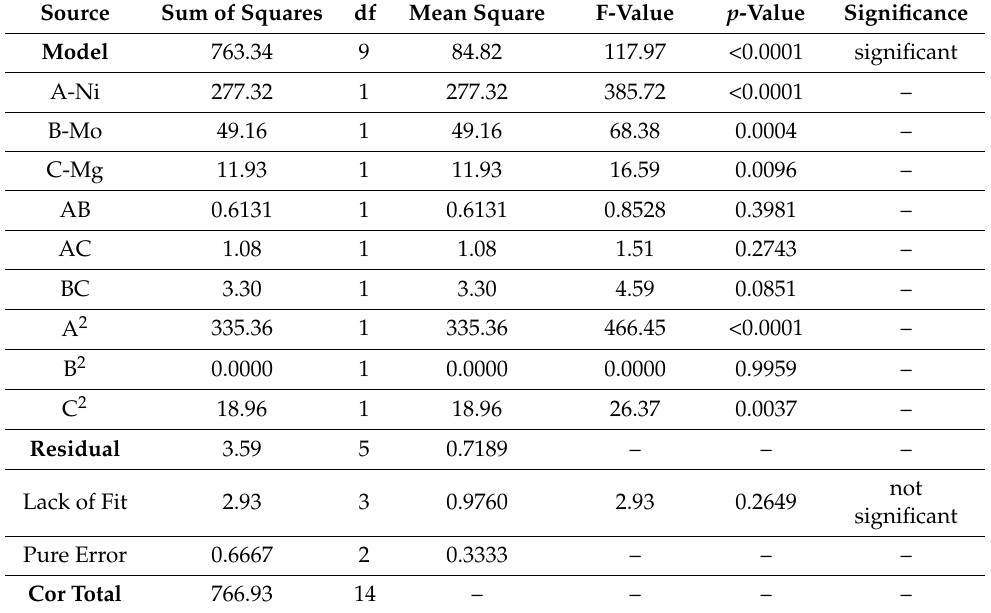
Table 4. ANOVA for Box–Behnken design for change in carbon yield due to different mole ratios of the catalyst